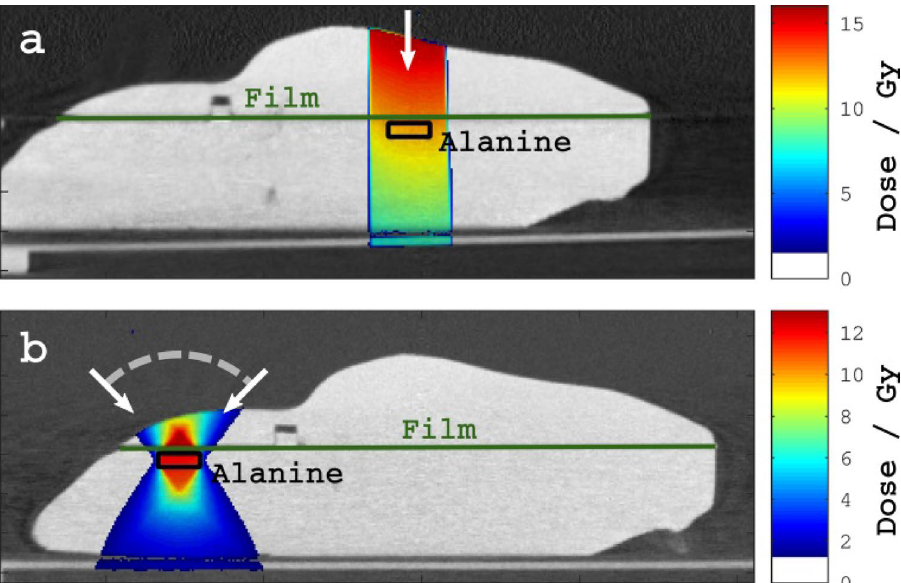
Figure 3. Illustration of the plan designs for ( a ) the simple irradiation of the pelvis using a static 10 × 10 mm static field, and ( b ) the more complex irradiation of the brain using a 90° arc in the sagittal plane and a 5 × 5 mm collimator. The arrows indicate the beam